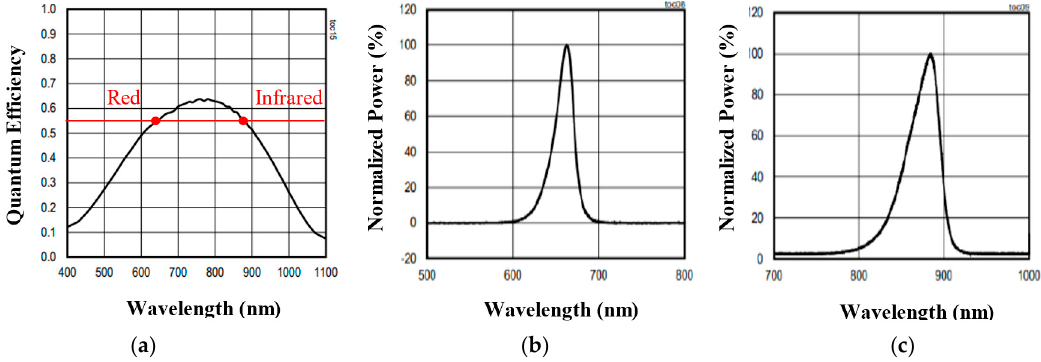
Figure 1. Photodiode Quantum Efficiency ( a ), Red ( b ) and Infra-red ( c ) light-emitting diode (LED). LSM6DSM. LSM6DSM is the accelerometer mounted on MORFEA and used in the apnea type